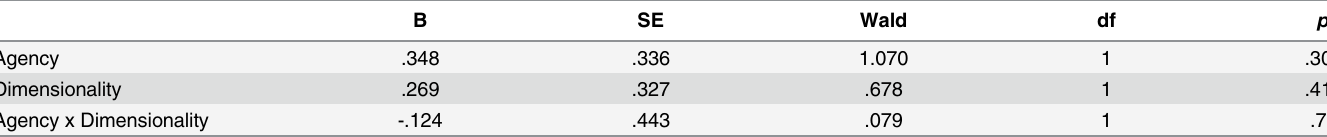
Table 1. Estimates and SE from logistic regression model. Table shows that dimension and agency used as predictors of logistic regression model do not predict likelihood of monetary contributions. Note: R 2 = .007 (Cox & Snell), .009 (Nagelkerke). Model χ 2 (3) = 2.42, p = 0.49.